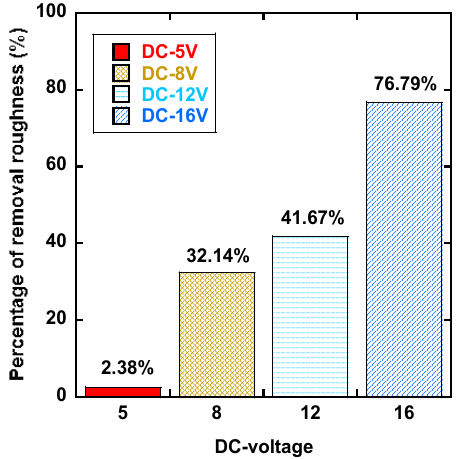
Figure 6. Percentage improvement in surface roughness according to different voltages.